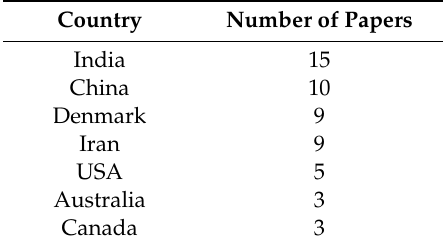
Table 2. Contributions by country.